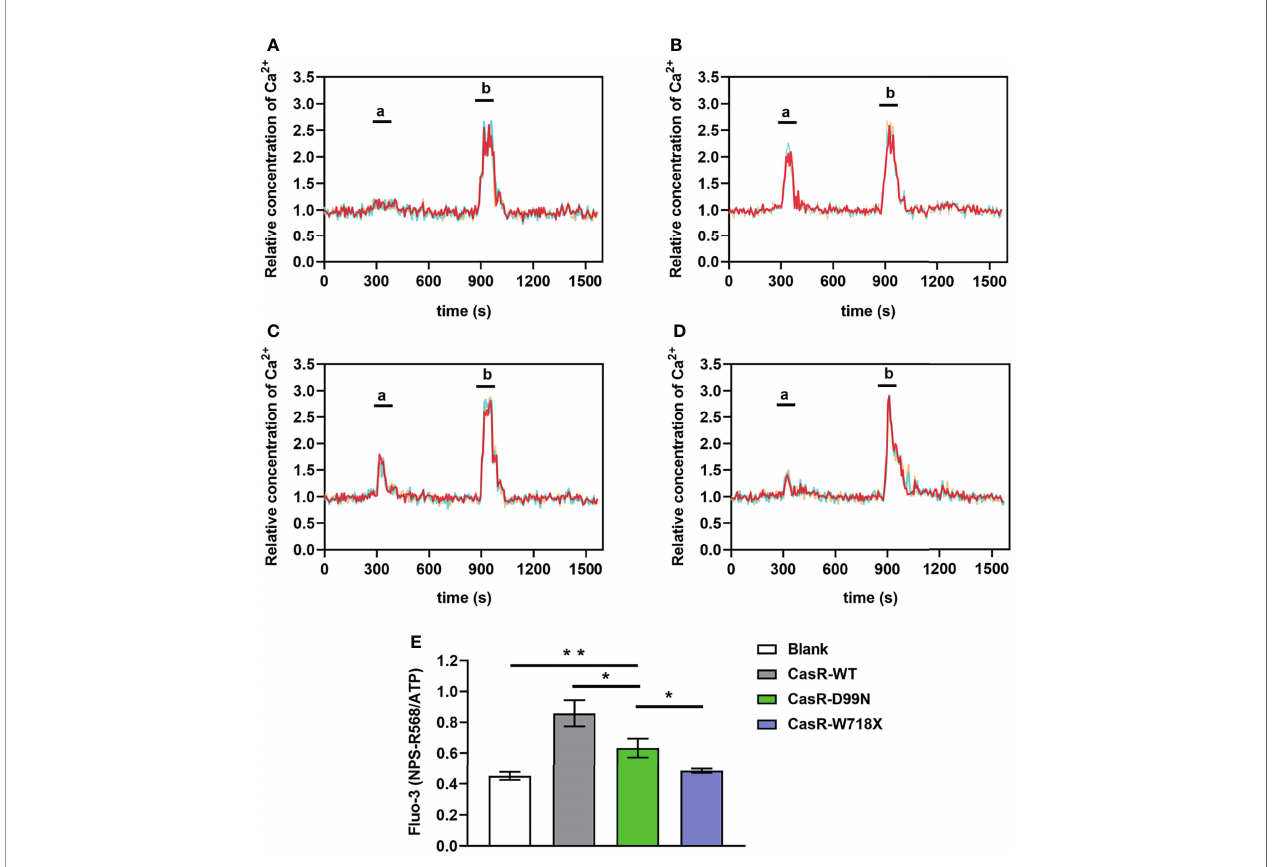
FIGURE 5 | Detection of intracellular calcium concentration using co-loadedFluo-3andFura Redprobes. (A – D) Changes in the ratio of Fluo-3/Fura Red fl uorescence in response to consecutive stimulation with 10 m M calcimimetics NPS R-568; peak ‘ a ’ ) and 100 m M ATP (peak ‘ b ’ ) were used as a measure of the intracellular Ca 2+ concentration in the blank (A) , CaSR-WT (B) , CaSR-D99N (C) , and CaSR-W718X (D) groups. (E) Relative fl uorescence values of NPS R-568/ATP (peak ‘ a ’ /peak ‘ b ’ in panels A – D ) in each group, re fl ecting the Ca 2+ concentration. Data were obtained from12 wells for each cell type and given as means ± S.E. Statistical signi fi cance was determined by Student ’ s test. *P < 0.05, **P < 0.01. Three separated tests were performed and both inter- and intra- assay coef fi cients of variability was less than